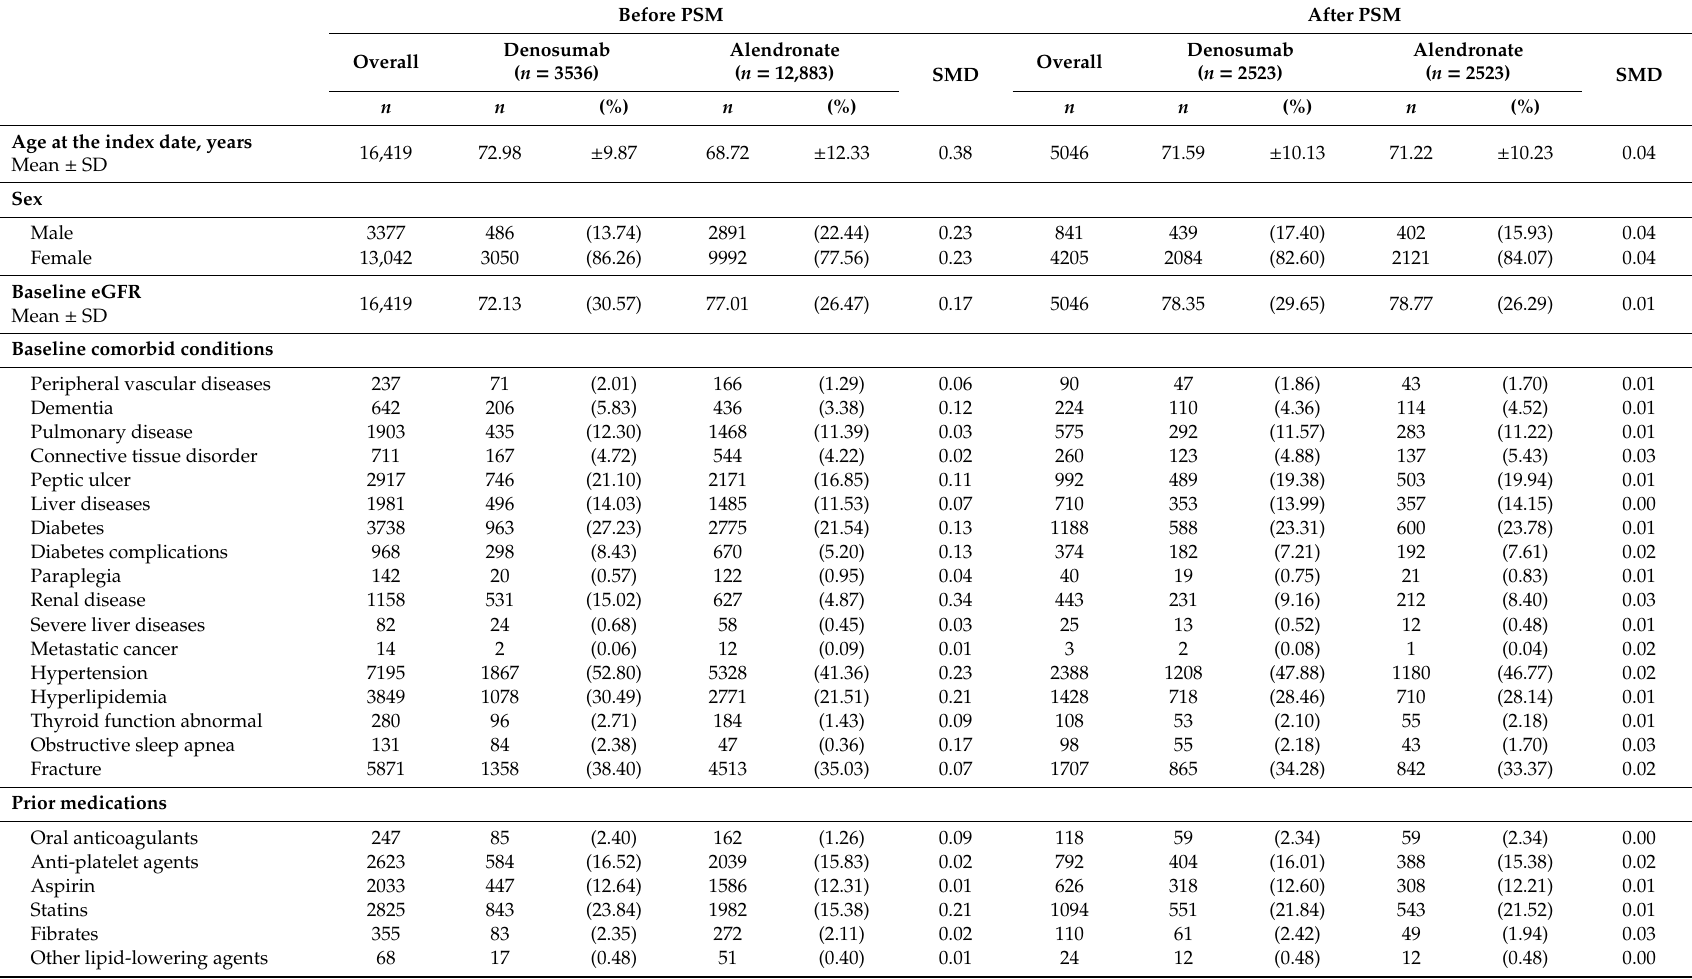
Table 1. Patient characteristics before and after